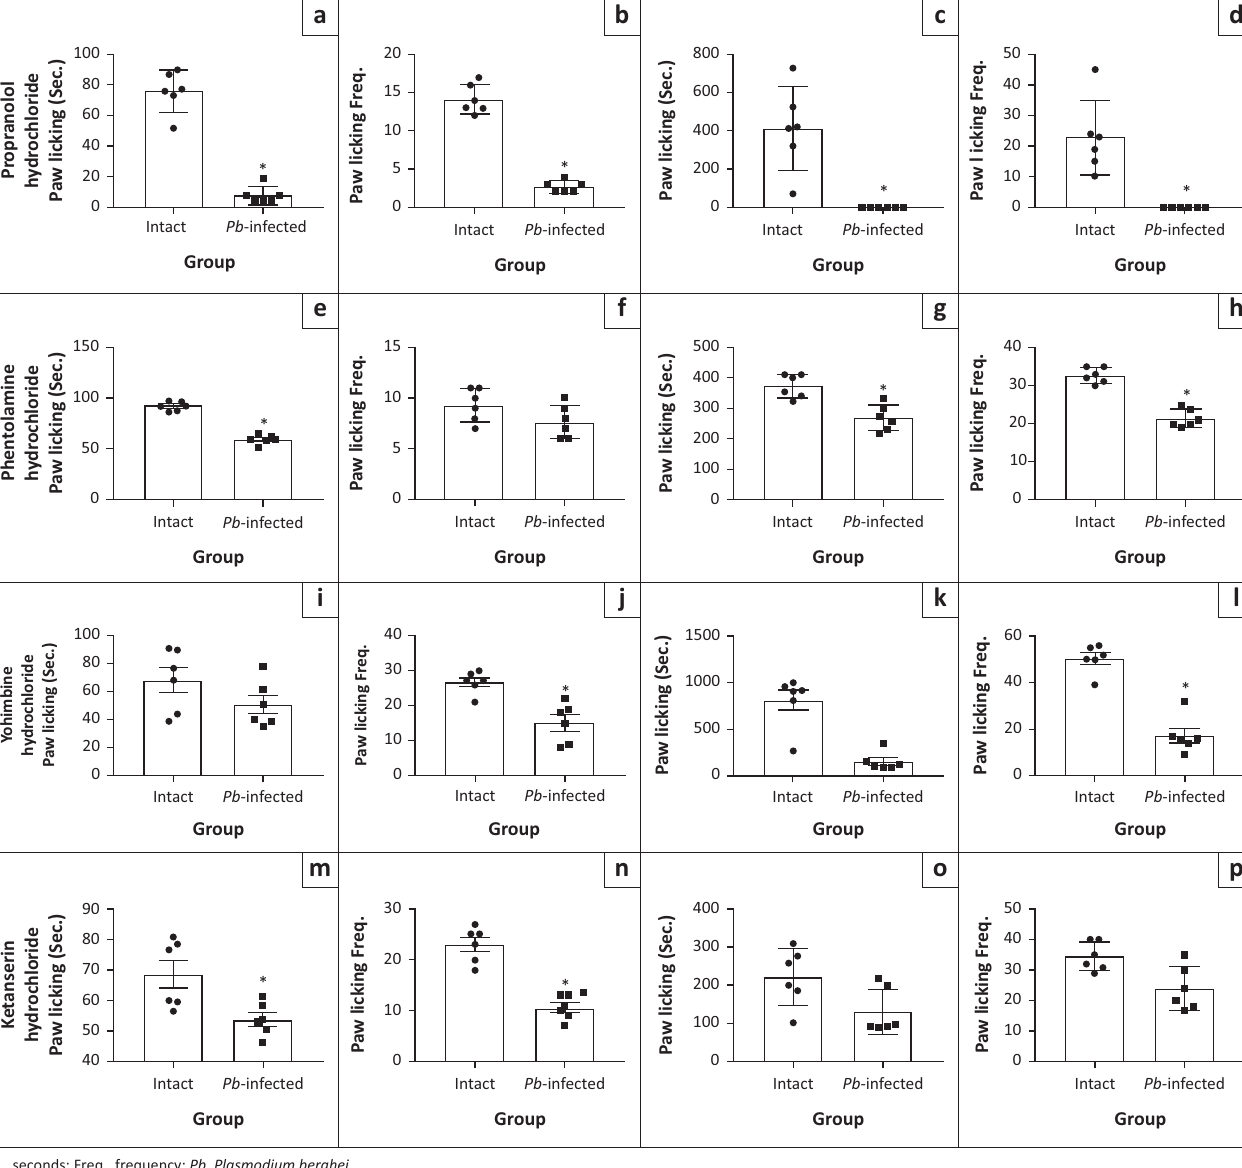
FIGURE 6: Role of adrenergic and serotoninergic system in Pb -induced analgesia. (a) and (b) Time spent and frequency of paw licking at the early phase (0–5 min) of formalin test in propranolol hydrochloride-treated mice, respectively. (c) and (d) Time spent and frequency of paw licking during the late phase (20–50 min) of formalin test in propranolol hydrochloride-treated mice, respectively. (e) and (f) Time spent and frequency of paw licking at the early phase (0–5 min) of formalin test in phentolamine hydrochloride-treated mice, respectively. (g) and (h) Time spent and frequency of paw licking at the late phase (20–50 min) of formalin test in phentolamine hydrochloride-treated mice, respectively. (i) and (j) Time spent and frequency of paw licking during the early phase (0–5 min) of formalin test in yohimbine hydrochloride-treated mice, respectively. (k) and (l) Time spent and frequency of paw licking during the late phase (20–50 min) of formalin test in yohimbine hydrochloride-treated mice, respectively. (m) and (n) Time spent and frequency of paw licking at the early phase (0–5 min) of formalin test in ketanserin hydrochloride- treated mice, respectively. (o) and (p) Time spent and frequency of paw licking during the late phase (20–50 min) of formalin test in ketanserin hydrochloride-treated mice,